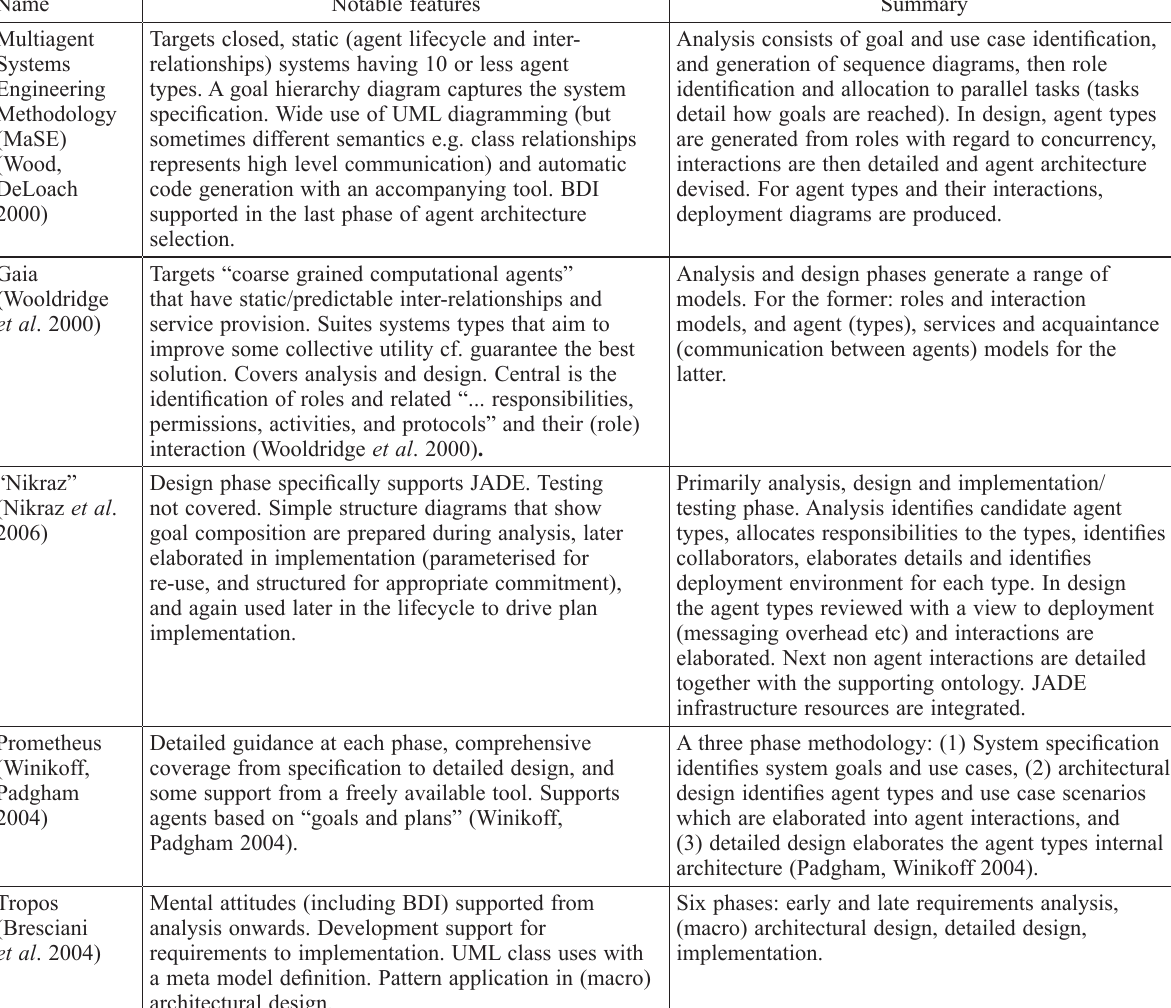
Table 1. selected MAs development